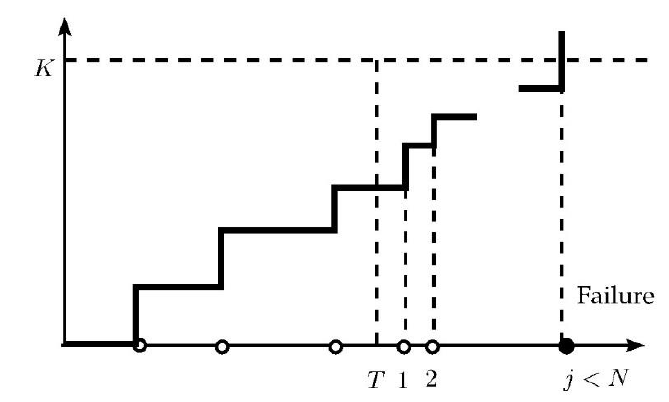
Fig. 2. Process for